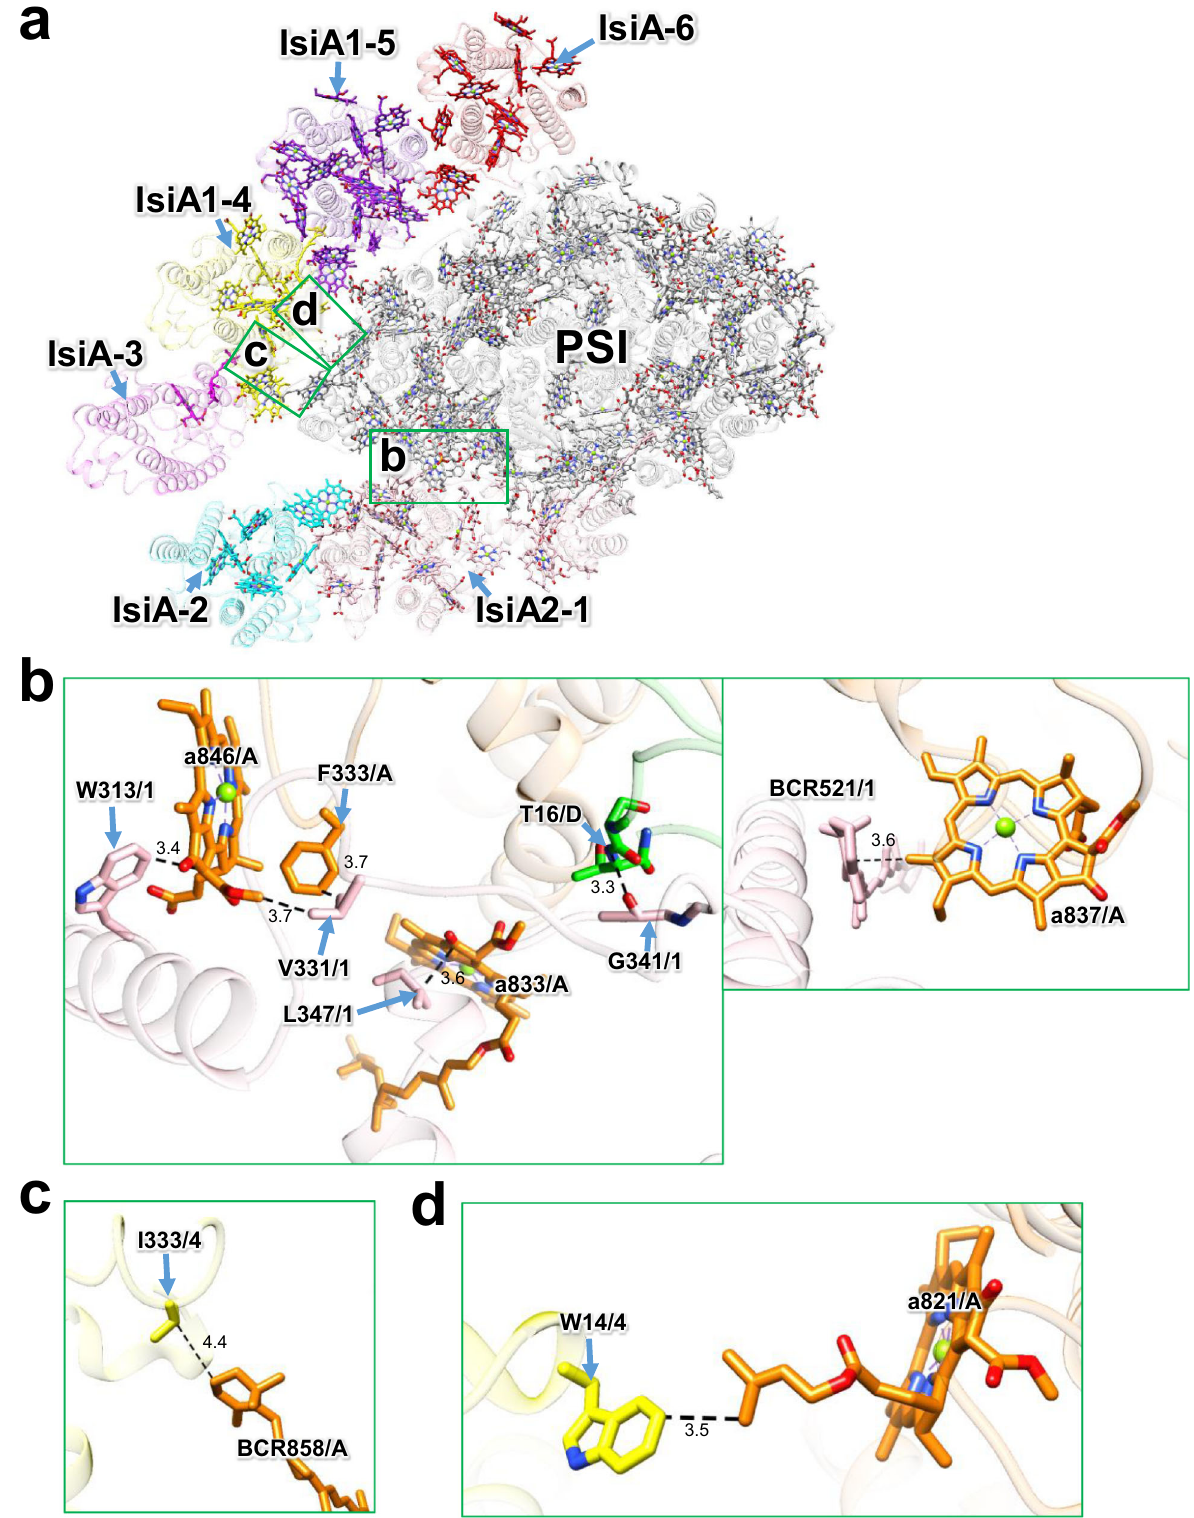
Fig.6|InteractionsbetweenIsiAsandPSI.a OverallstructureofPSI-IsiAviewed from the cytosolic side. Green squared areas are enlarged in panels b – d . b Interactions between IsiA2-1 and PsaA/PsaD (left and right panels). c InteractionbetweenIsiA1-4andPsaA. d InteractionbetweenIsiA1-4andPsaA.